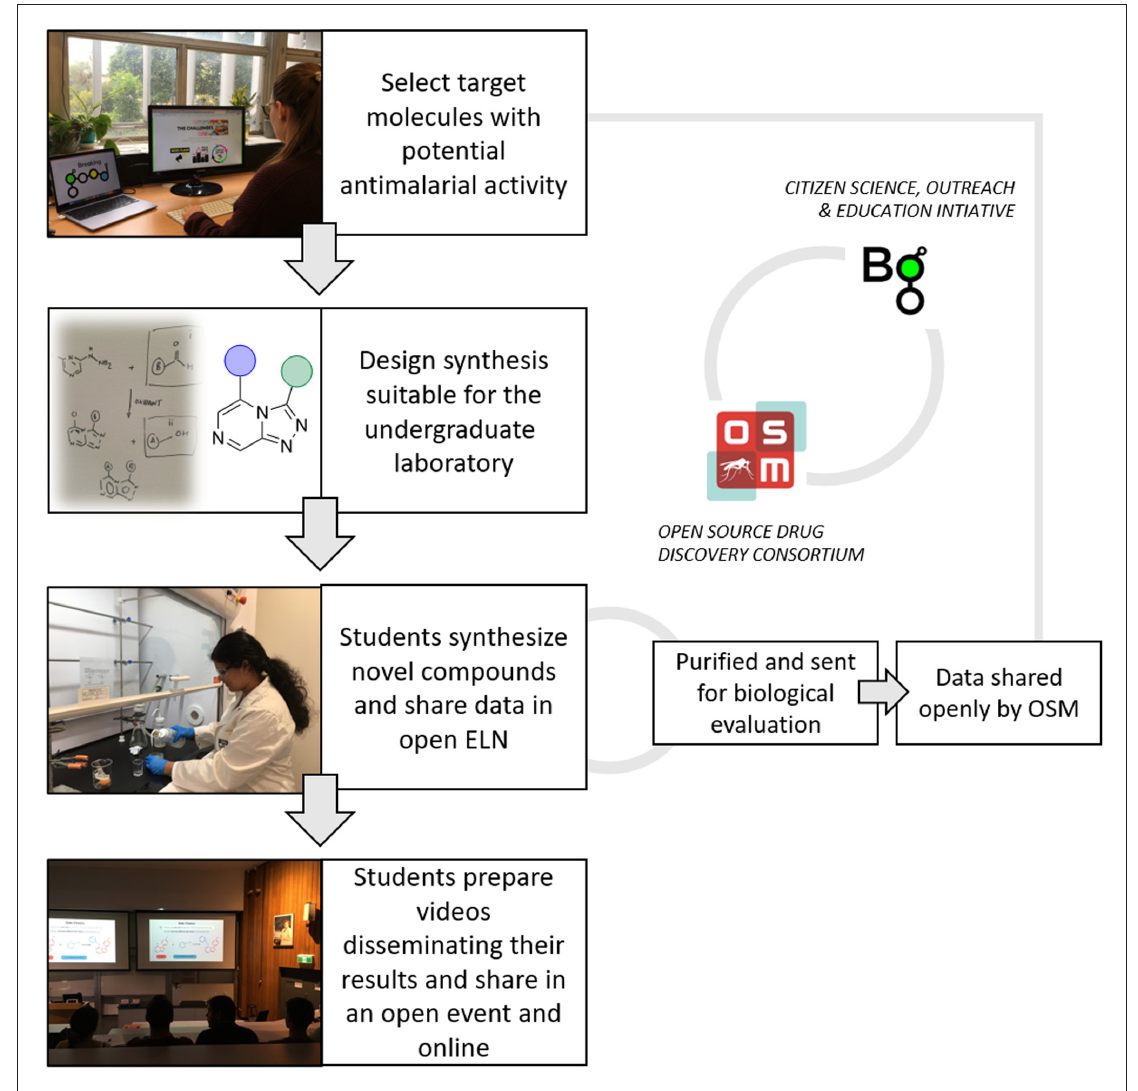
Figure 1 Structure of the Breaking Good Special Studies Program (SSP)